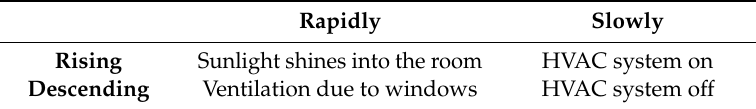
Table 5. Expected Events in the Room by Analyzing the Temperature